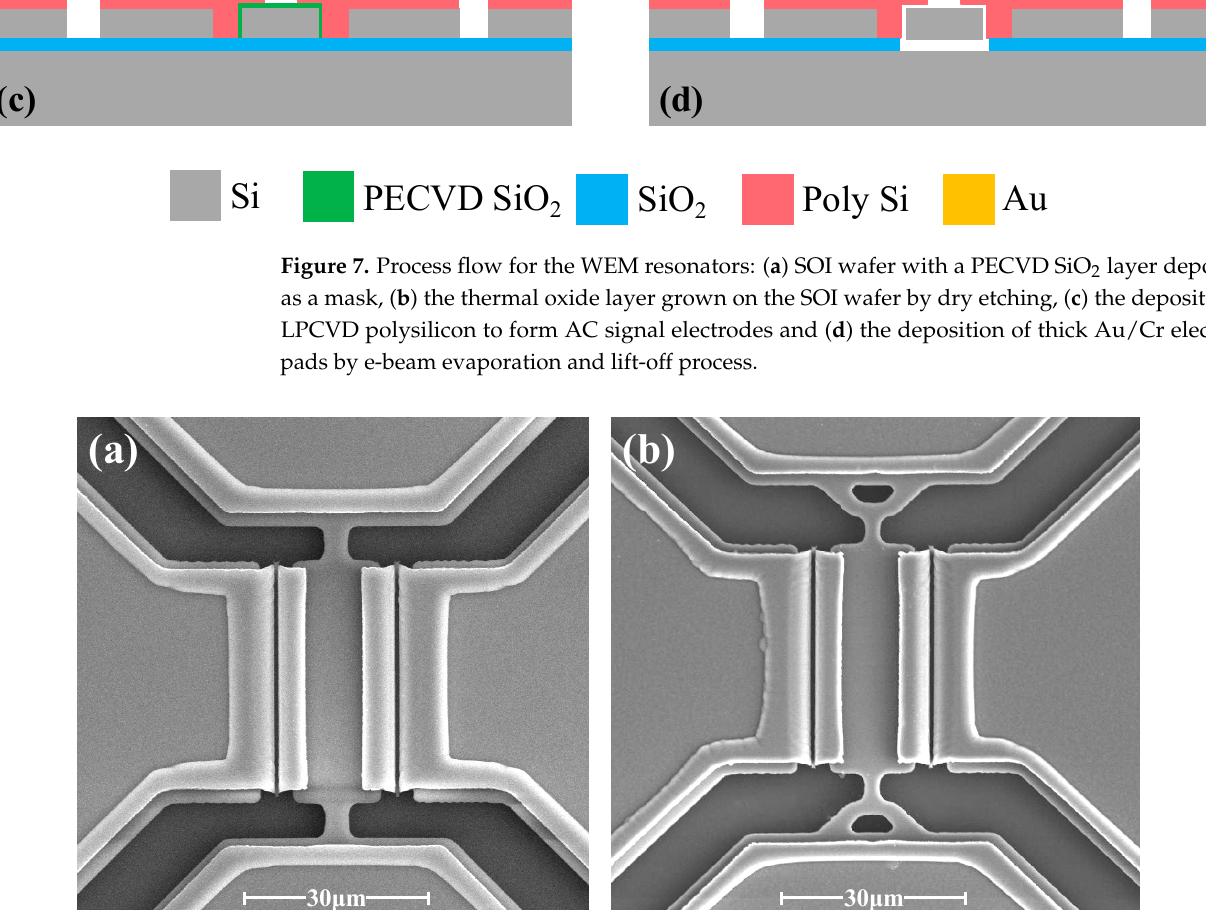
Figure 8. SEM photographs of the WEM resonators supported by ( a ) the straight tethers and ( b ) the combined tethers.